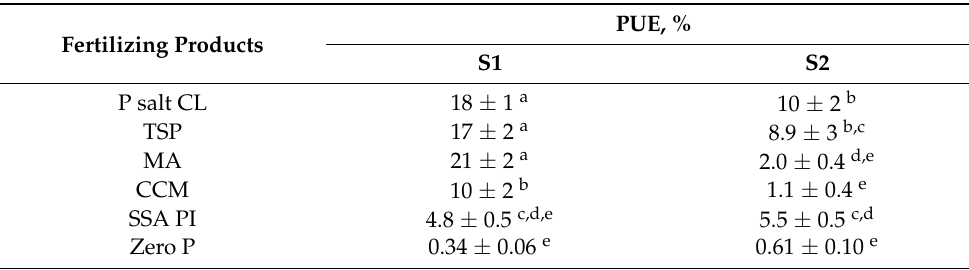
Table 4. Phosphorus uptake efficiency (PUE, %) of fertilizing products after four months of ryegrass at two